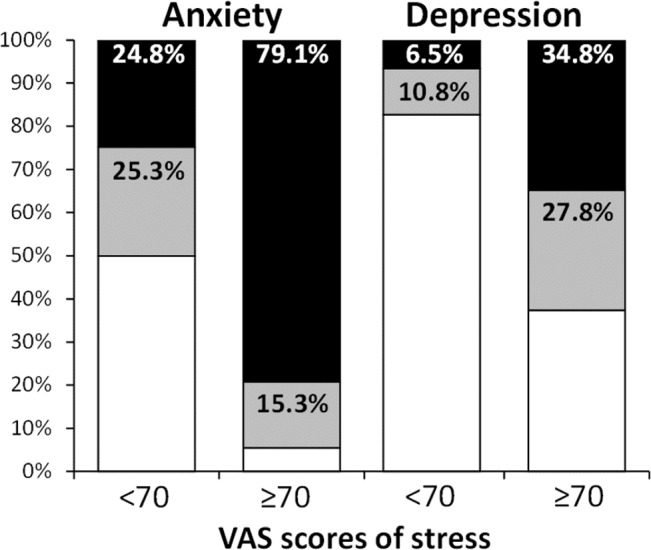
Proportion of anxiety and depression (normal, suggestive and indicative scores) according to work-related stress (<70 and ≥70/100).Anxiety and depression are presented according to normal (white), suggestive (grey) and indicative scores (black) of the HADS. Proportions of anxiety and depression scores were significantly different between higher stressed participants and lower stressed (p < 0.001).